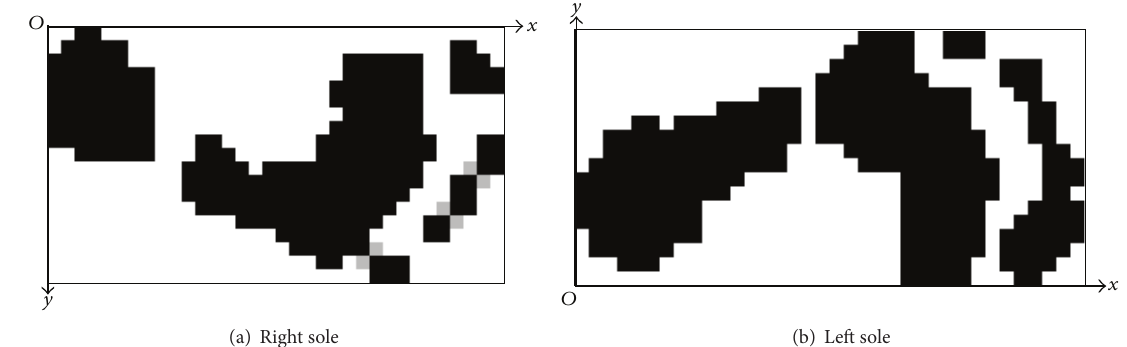
Figure 5: Right and left sole coordinate systems.